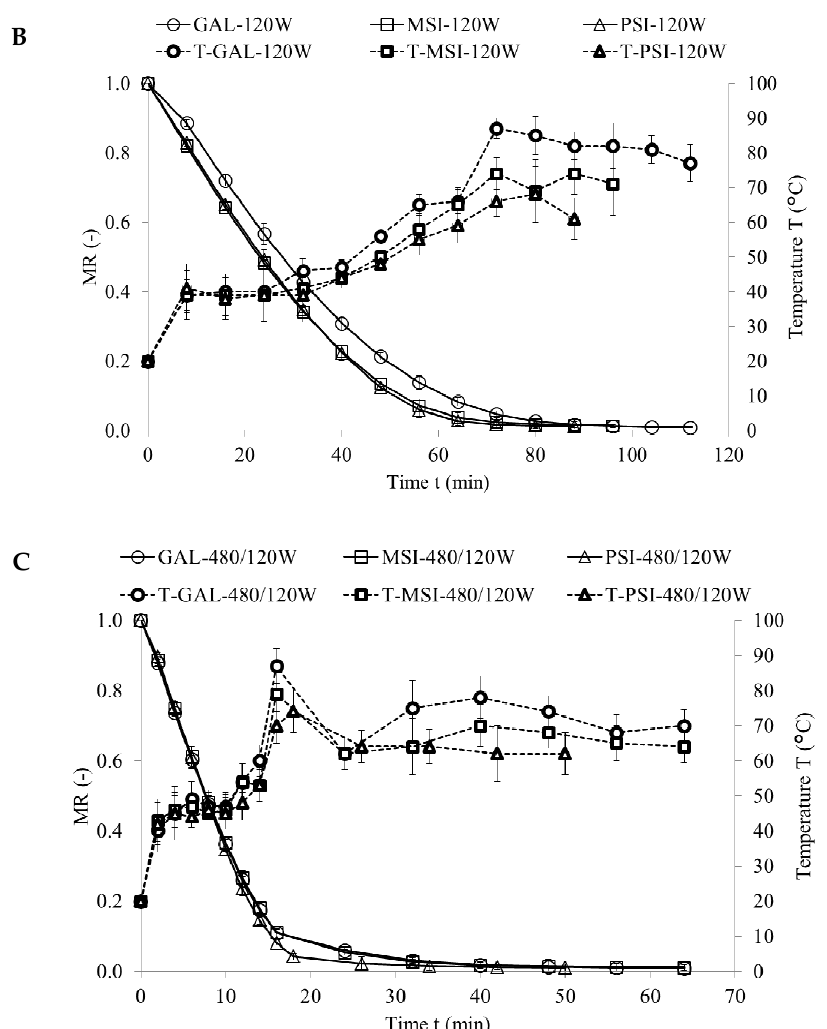
Figure 2. ( A ) Drying kinetics of jujube fruits during VMD 480 W; ( B ) Drying kinetics of jujube fruits during VMD 120 W; ( C ) Drying kinetics of jujube fruits during VMD 480/120 W.